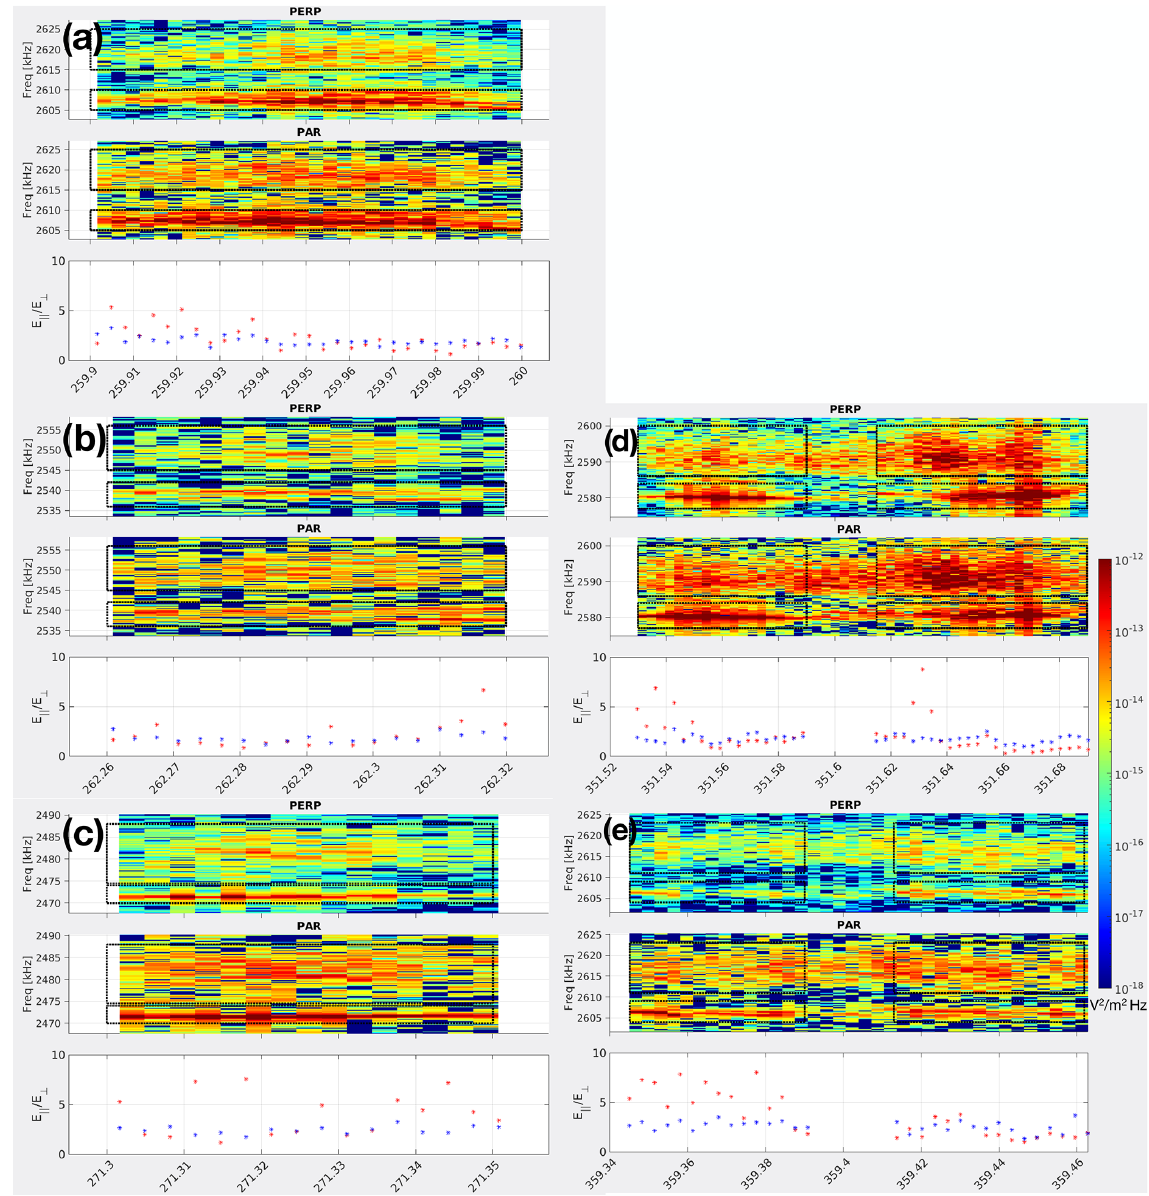
Figure 4. Enhanced plots of the five Langmuir bursts indicated in Fig. 2, presented in time order, each comprised of a narrow band plasma line and a broadband diffuse feature with ∼ 5–15kHz higher frequency. The top panels in each plot are from the perpendicular antenna, the middle panels are from the parallel antenna, and the bottom panels are the parallel to perpendicular ratios of the amplitudes of the plasma peaks (red) and the diffuse feature